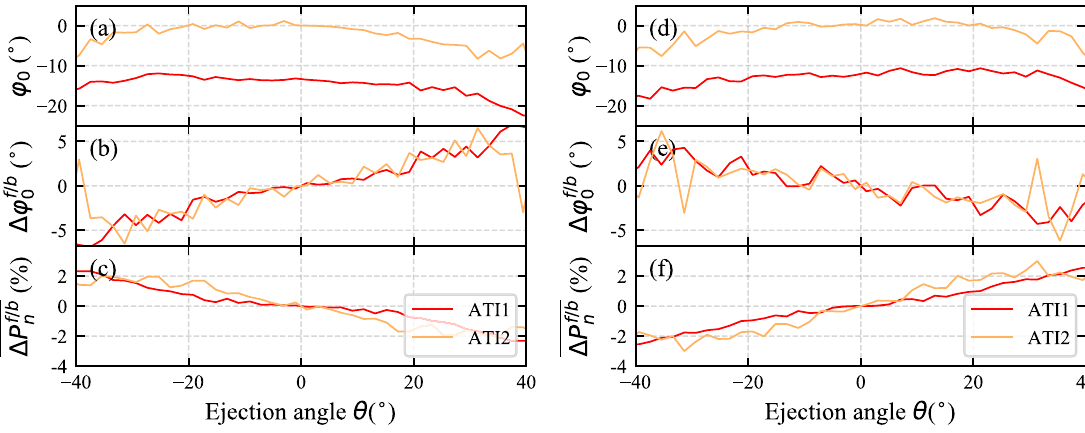
FIG. 10. Enantiosensitivity of attoclock measurements in camphor at I ¼ 8 × 10 12 W : cm − 2 with r ¼ 1 . (a) Attoclock streaking angle φ θ in ( þ )-camphor. (b) Forward-backward asymmetry in the 0 of the first two ATI peaks as a function of the electron ejection angle attoclock streaking angles Δ φ f=b 0 ð θ Þ . (c) Forward-backward asymmetry in the intensity of the ATI peaks, Δ P f=b n ð θ Þ . (d) – (f) are identical to (a) – (c) but relative to ( −